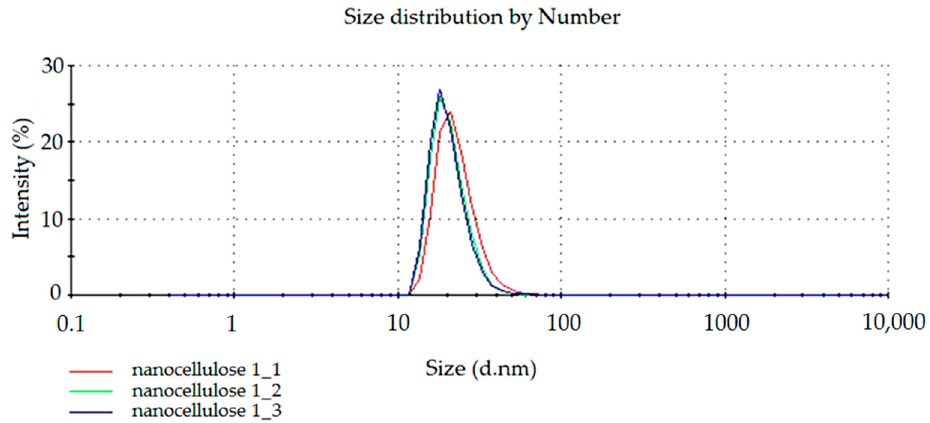
Figure 2. The spectrum of dependence of the number of particles on their size.